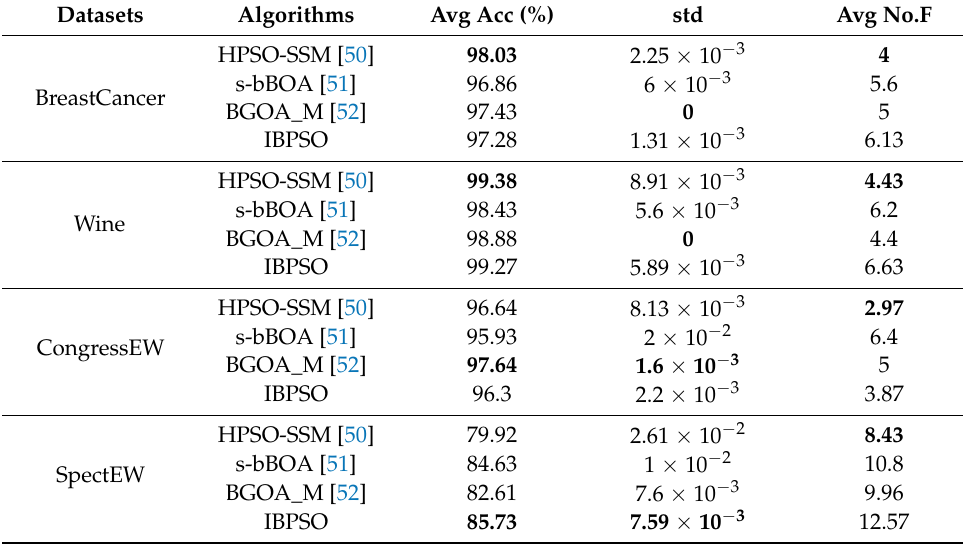
Table 6. Comparison between IBPSO and state-of-the-art models.